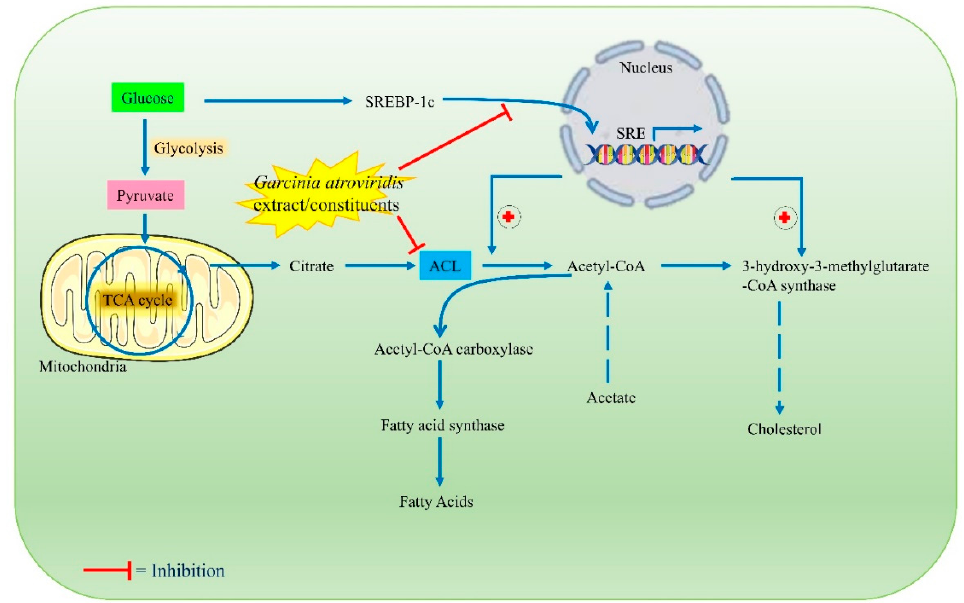
Figure 5. Probable antihyperlipidemic/anti-obesity mechanisms of action of G. atroviridis extracts or its constituents.